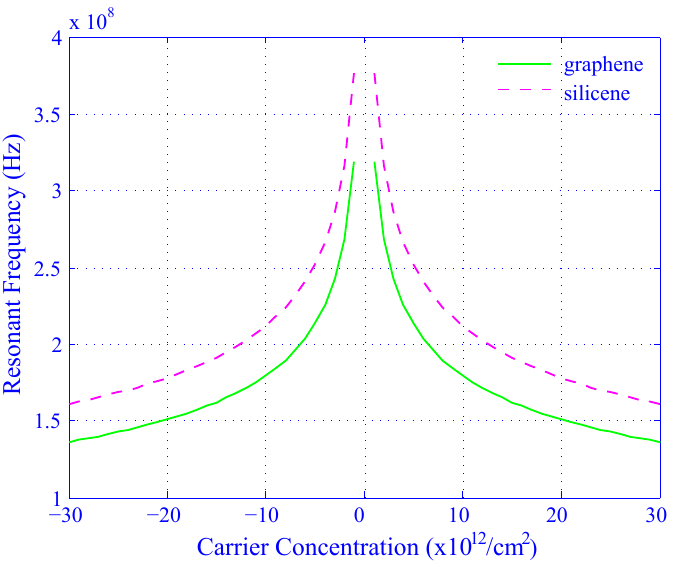
Figure 10. Effect of carrier concentration on the resonant frequency for both silicene (dotted line) and graphene (solid